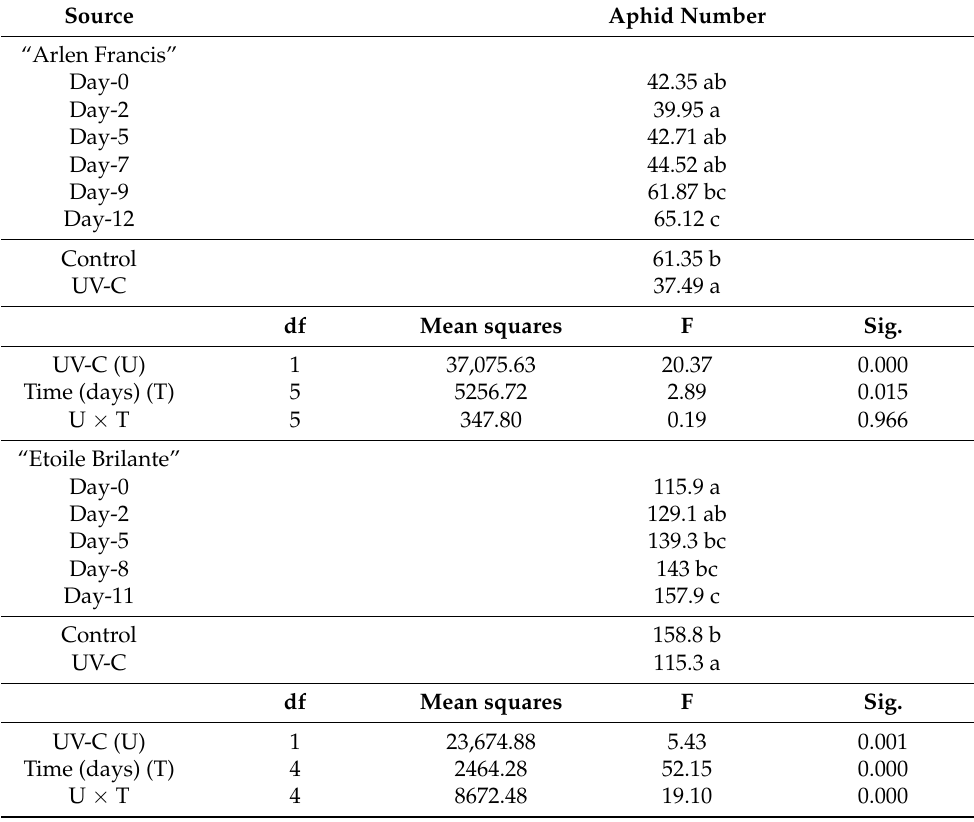
Table 2. Main factor means of aphid number, degrees of freedom (df), mean squares, F-values (F) and significance (Sig.) for time (T) and UV-C irradiation (U). Data were subjected to univariate ANOVA, and means were separated using the Duncan’s multiple range test at p = 0.05. Different letters indicate significant differences between the levels of each